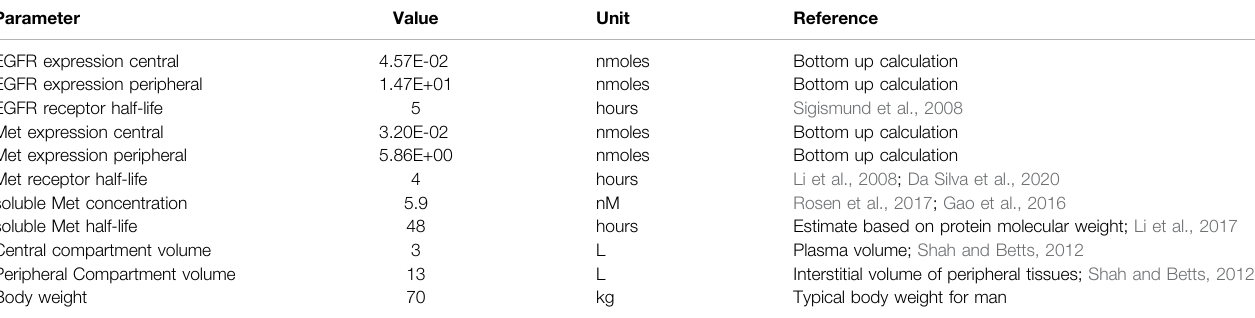
TABLE 3 | EGFR and c-met target parameters. Parameter